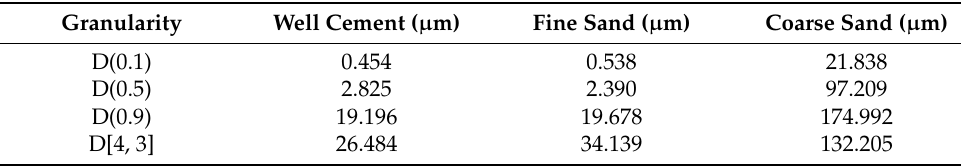
Table 1. Material particle size distribution.